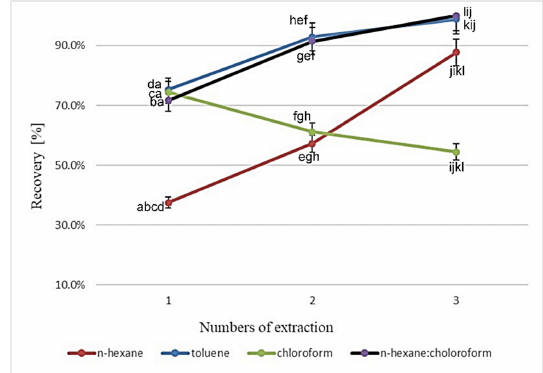
Figure 1. The effect of extraction numbers on the cholesterol recovery from butter sample applying various solvents: n-hexane, toluene, chloroform and the binary mixture of n-hexane and chloroform Different letters indicate significant difference at p < 0.05. Foods 2020 , 9 , x FOR PEER REVIEW